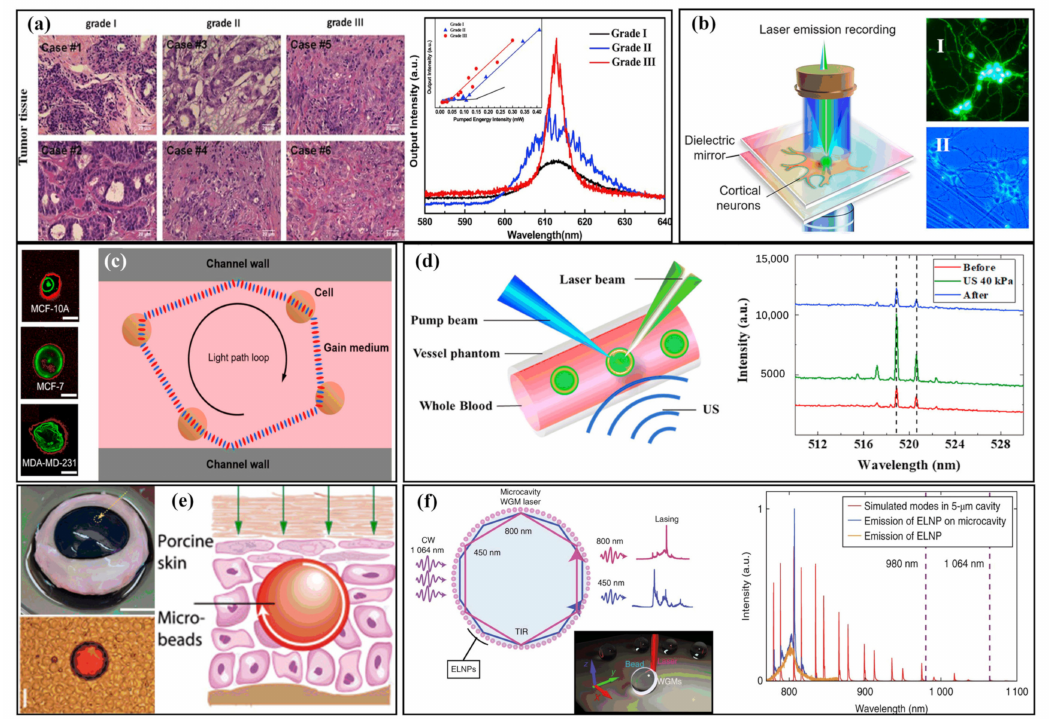
Figure 5. Tissue-based sensing with microlasers. ( a ) Microscopic pictures with HE dye and lasing spectra of human breast tumor tissues: malignancy grade I, malignancy grade II, and malignancy grade III. (Adapted from [83].) ( b ) Diagram of the laser path loop in a biofluidic random laser. The pink background indicates the gain medium in the solution. I, II, III: Immunostaining of three kinds of cells. (Adapted with permission from [87]. Copyright 2019 American Chemical Society.) ( c ) Diagram of the configuration for neuron lasing, where neurons are trapped in an FP cavity composed of two highly reflective mirrors. I: Fluorescence image of OGB-1-labeled primary rat cortical neurons cultured on a mirror. II: Brightfield image of a neuron on a mirror. (Adapted with permission from [76]. Copyright 2020 American Chemical Society.) ( d ) I: Position of injection of the bead microcavity dispersion. II: A 40 µ m diameter bead in blood. The beads are surrounded by red blood cells. III: Principle of operation of a laser in skin tissue. (Adapted with permission from [77]. blood. II: Laser spectroscopy of oil droplet laser mixing human whole blood and applying